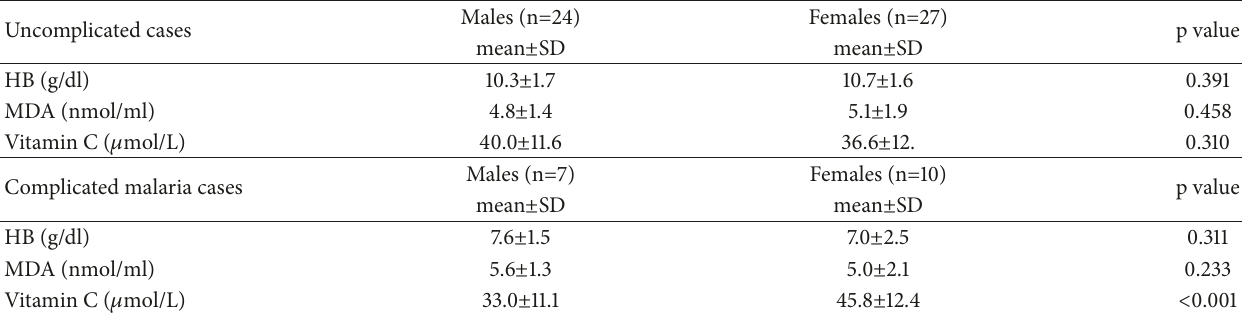
Table2:Comparisonofhemoglobin,serumMDA,andvitaminClevelsaccordingtogenderbetweenuncomplicatedandcomplicatedmalaria